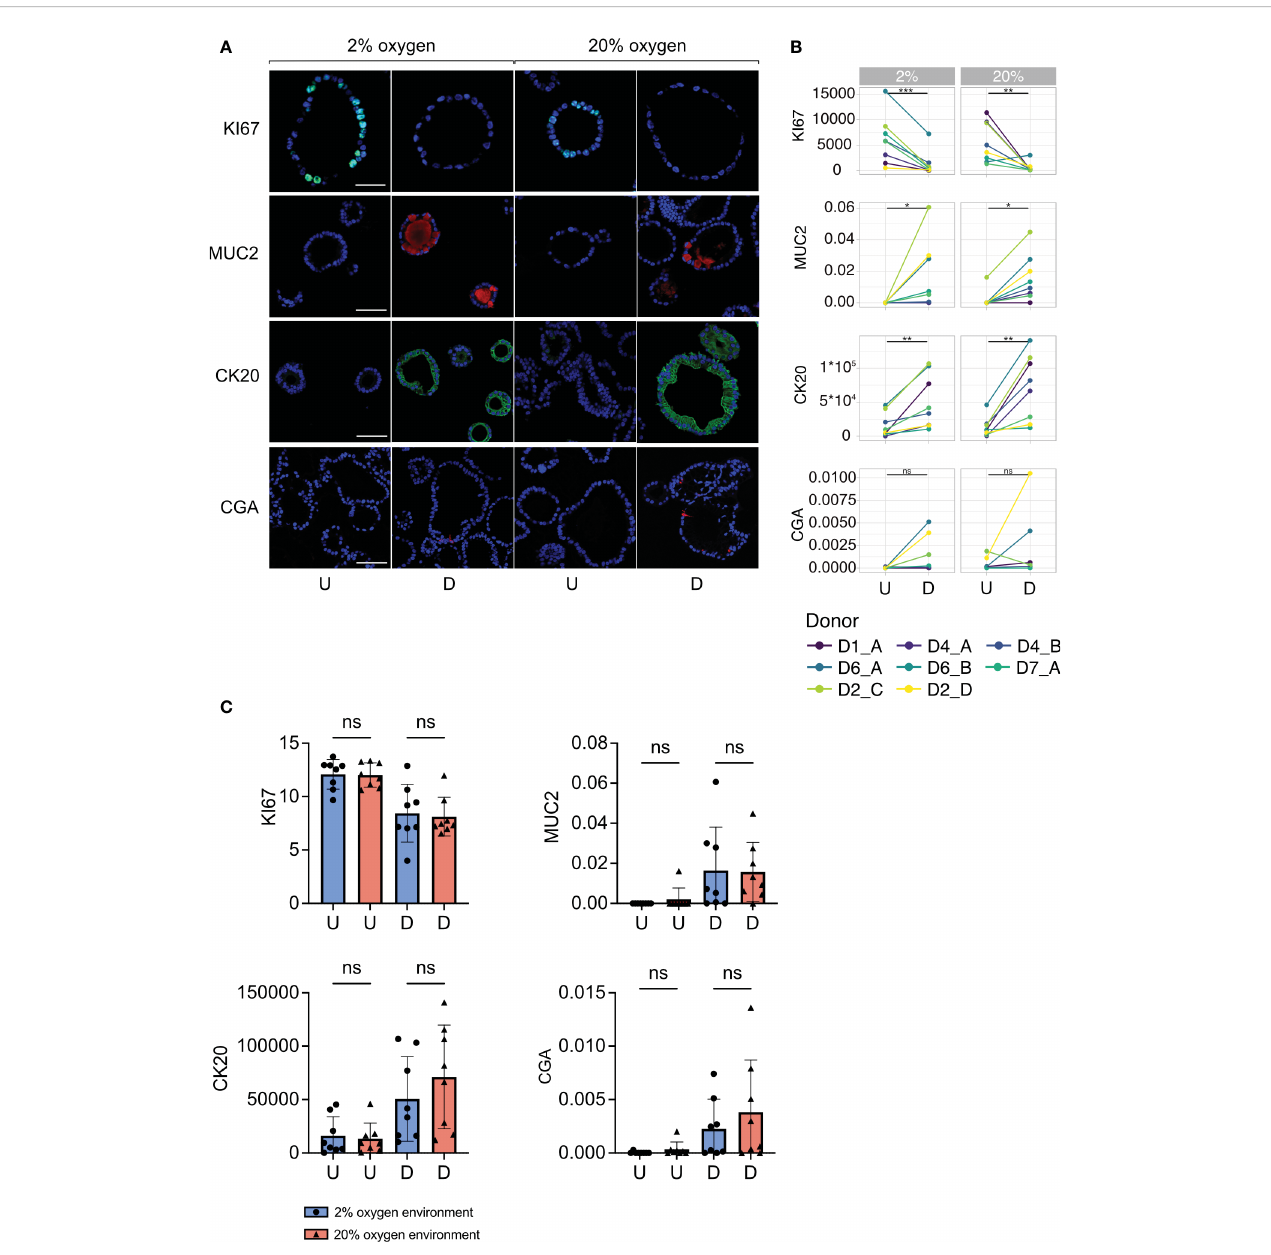
FIGURE 3 Cell marker protein expression in undifferentiated and differentiated colonoids at low and high oxygen. (A) Immuno fl uorescent images of cell marker expression. Images in the two fi rst columns show colonoids cultured in 2% oxygen, while the images in the last two columns show colonoids cultured in 20% oxygen. Within each oxygen concentration, U indicates the undifferentiated condition, while D indicates the differentiated condition. Each row represents a cell marker protein. DAPI was used as a counterstaining in all images. Scalebar = 50 m m. (B) Paired quanti fi cation of cell marker expression in undifferentiated (U) and differentiated (D) colonoids (n=8 independent experiments, Table 1). Statistical testing was carried out with the Wilcoxon test. The x-axis shows the differentiation condition of the colonoids while the y-axis shows calculated expression: CK20 and KI67 expressions were quanti fi ed with corrected total cell fl uorescence (CTCF) adjusted for the number of cells present. The y-axis for MUC2 and CGA indicates the fraction of positive cells, manually counted, among all present cells. (C) Cell marker protein expression in colonoids cultured at 2% vs . 20% oxygen. The bars show the mean and standard deviation with each independent experiment plotted as individual values. Blue bars and dots illustrate colonoids cultured in 2% oxygen and red bars and triangles cultured in 20% oxygen. The x-axis shows the conditions undifferentiated (U) or differentiated (D), while the y-axis shows cell marker expression. P-values are determined by one-way ANOVA followed by S ̌ ida ́ k ’ s multiple comparisons test. ns = non-signi fi